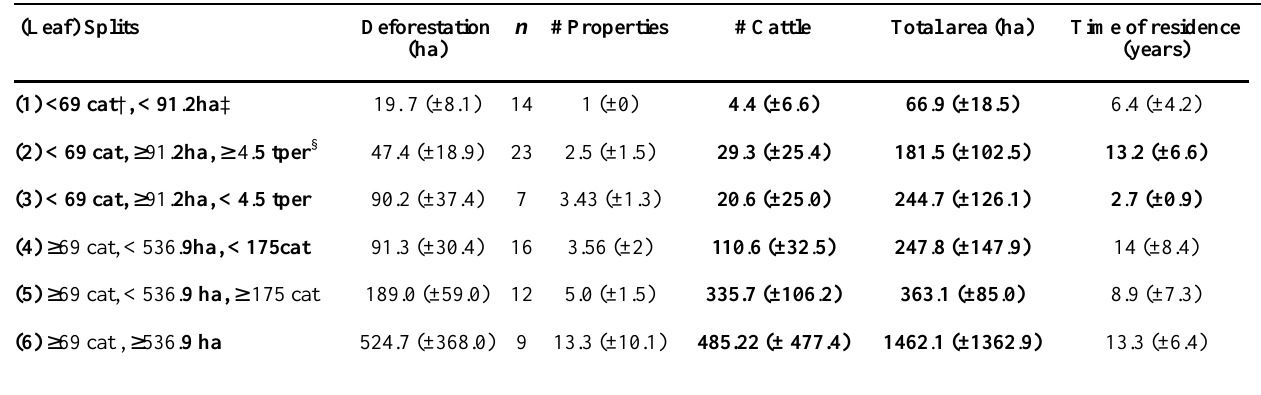
Table 3. Leaves formed by the regression-tree analysis of deforestation and mean values (standard deviation) of the variables acting as splits